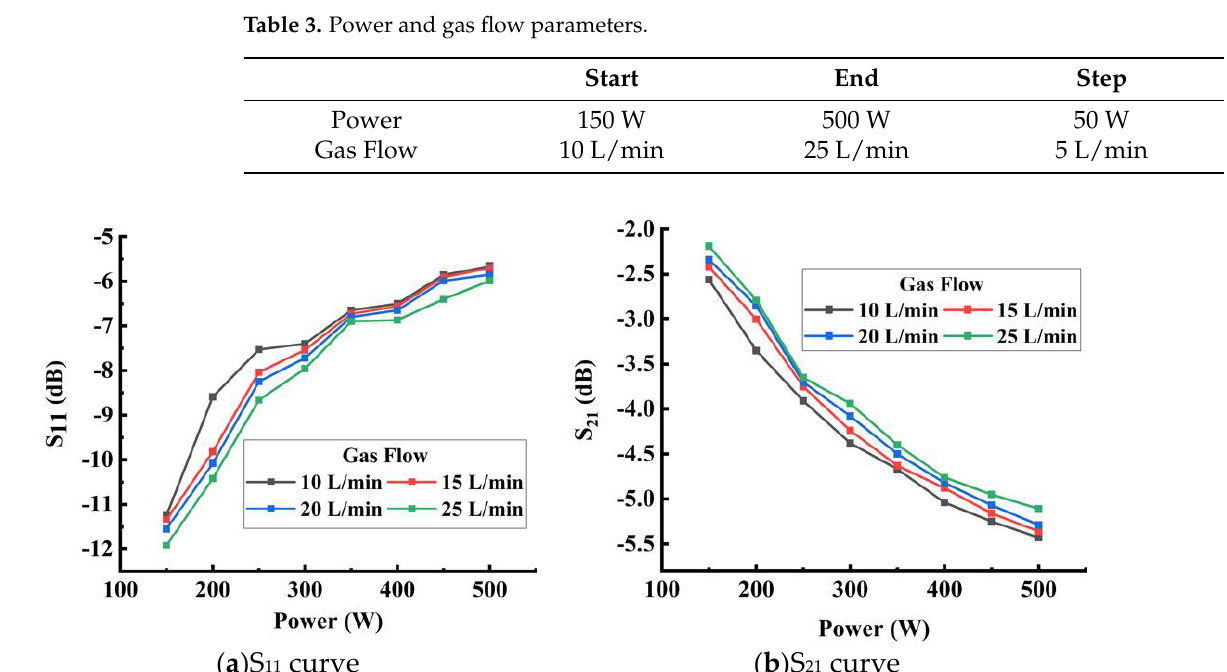
Table 3. Power and gas flow parameters.